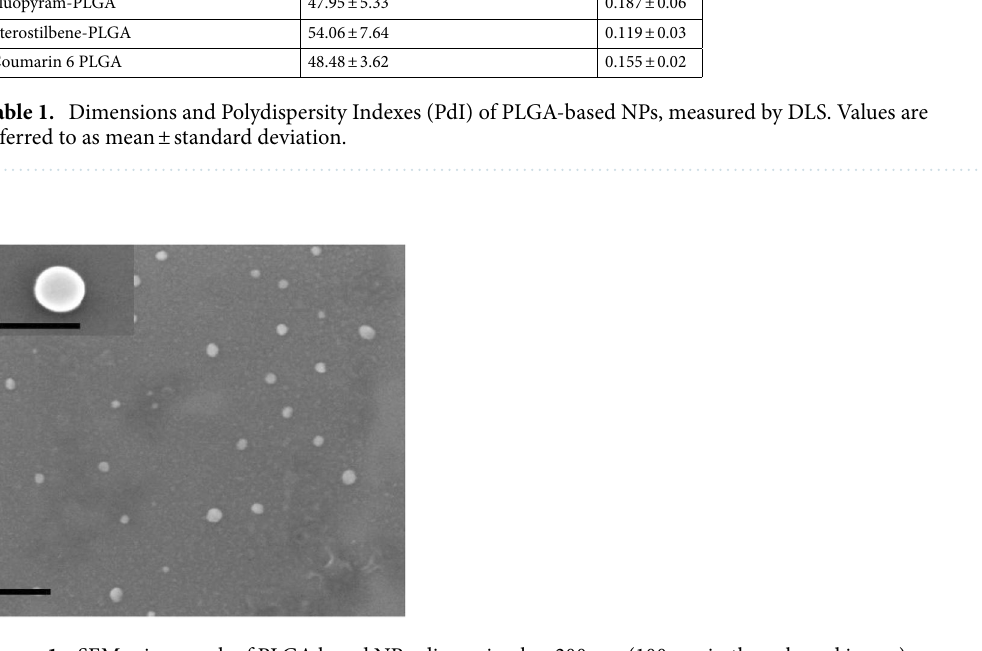
Figure 1. SEM micrograph of PLGA based NPs, dimension bar 200 nm (100 nm in the enlarged image).